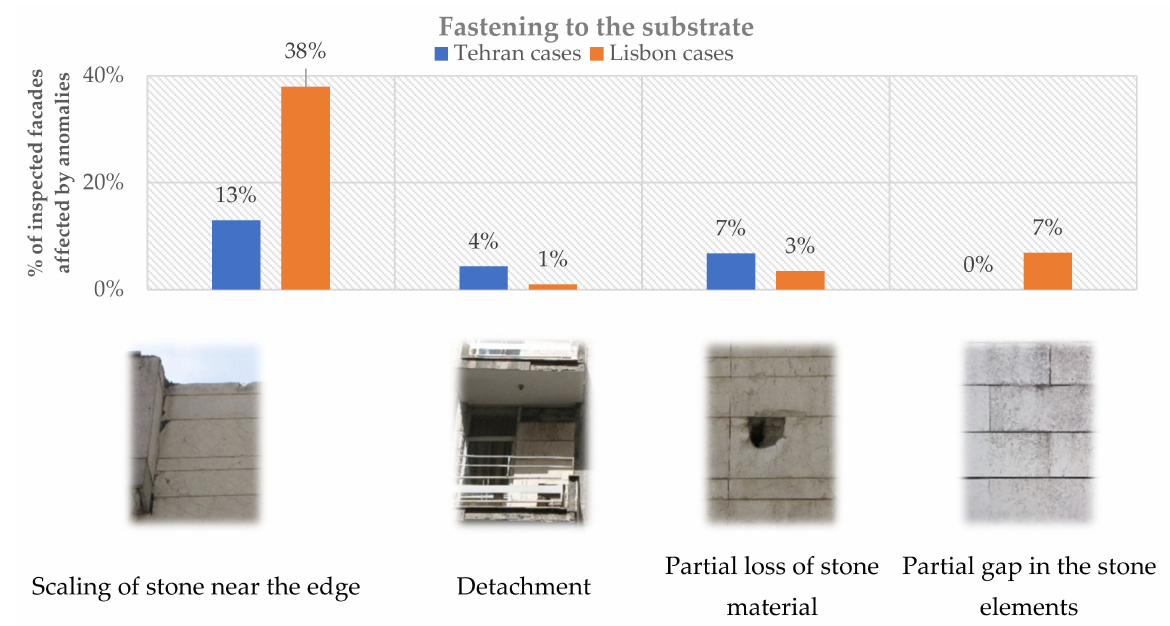
Figure 6. Frequency of the fastening to substrate defects in the samples under analysis.